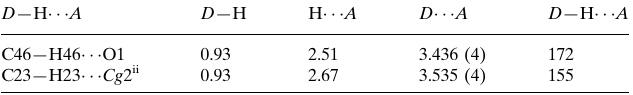
Hydrogen-bond geometry (A˚ , (cid:2)